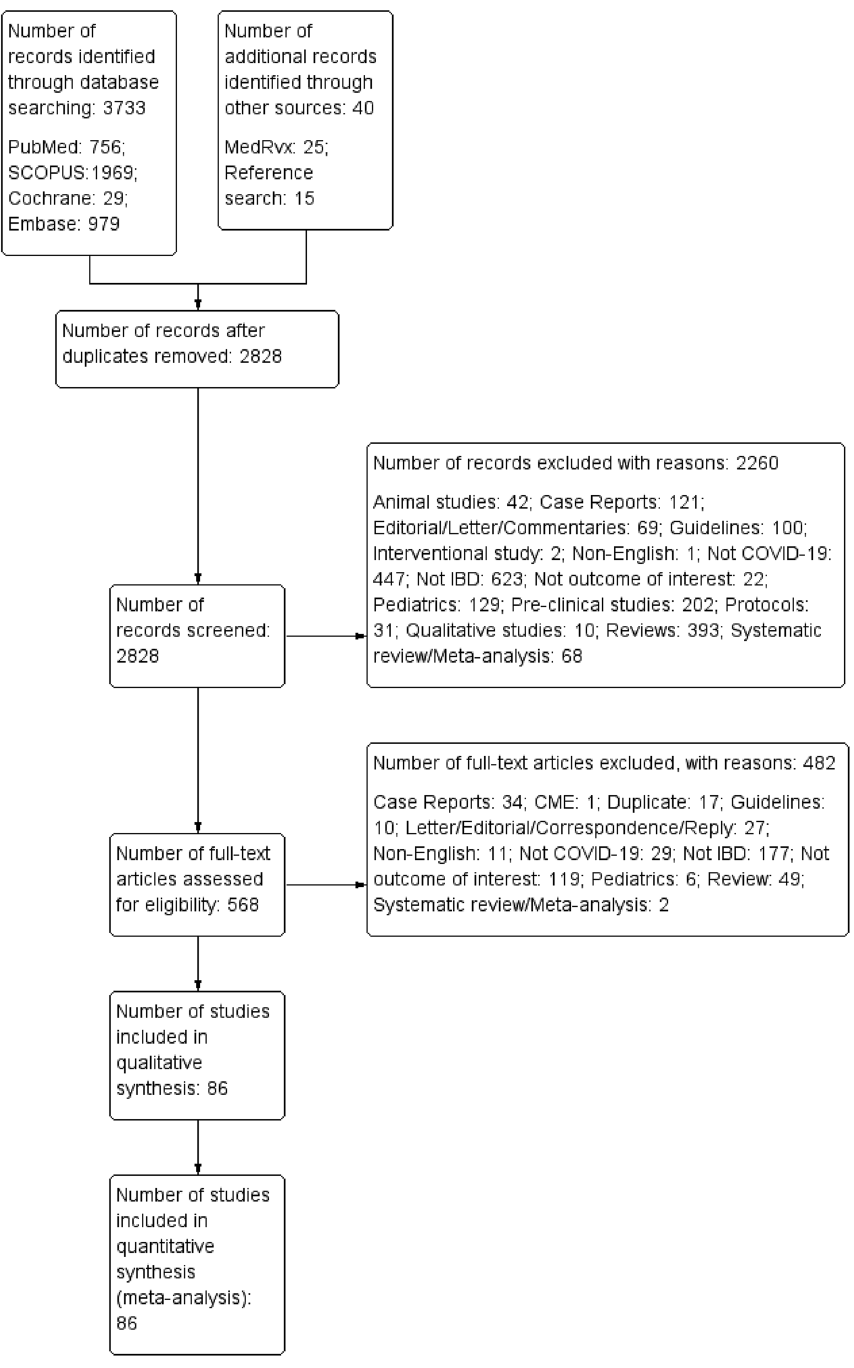
Figure 1. Study selection